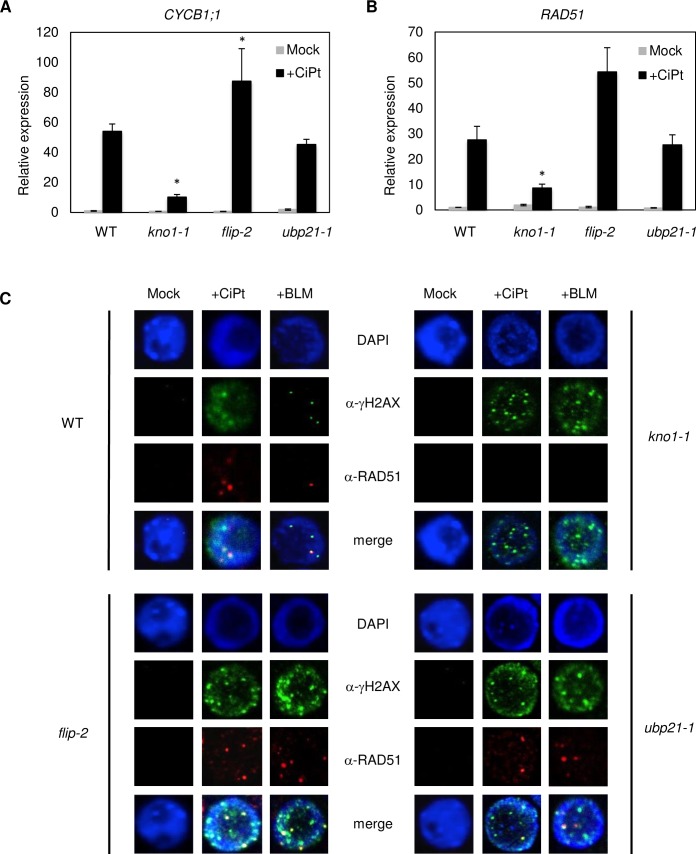
KNO1 is needed for RAD51 localization.Expression of (A) CYCB1;1 and (B) RAD51 in the wildtype as well as in kno1-1, flip-2, and ubp21-1 mutant seedlings as detected by qRT-PCR after 3 hr treatment with and without 50μM cisplatin. Statistically significant differences in expression compared to the corresponding wildtype sample are marked by an asterisk (p<0.05). (C) Root cell nuclei of the wildtype and kno1-1, flip-2 and ubp21-1 mutants incubated with an anti-γH2AX antibody and an anti-RAD51 antibody after 3 hr treatment of seedlings with cisplatin and bleomycin in comparison with mock treated samples.